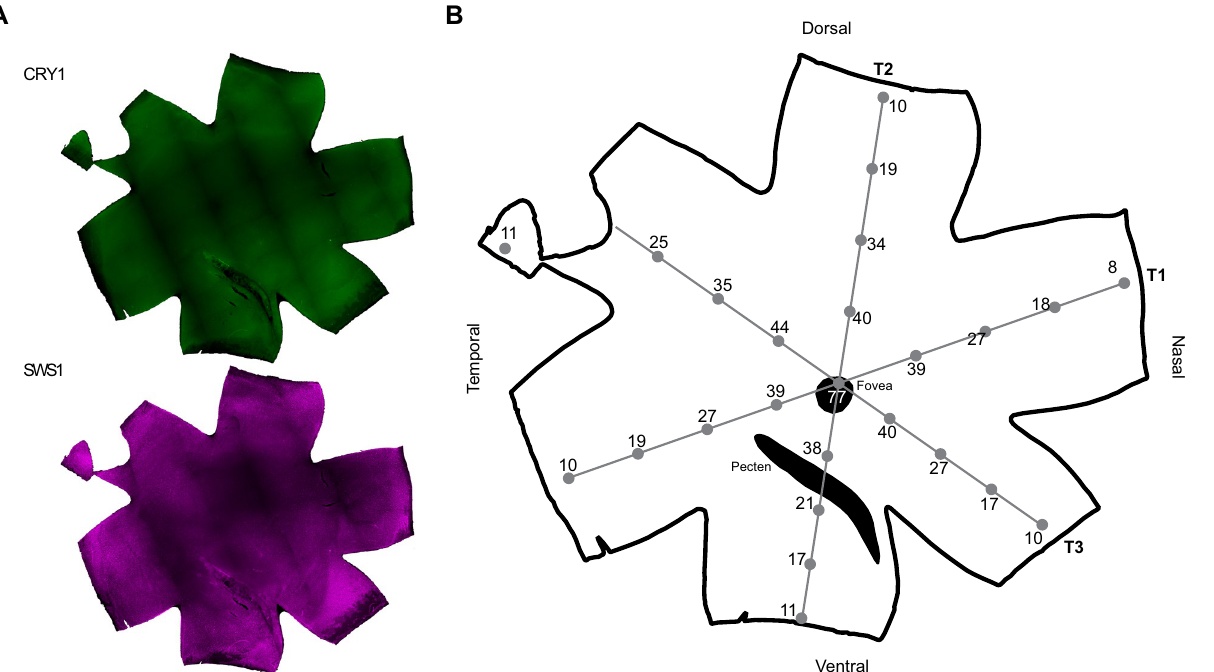
Figure 4. Example of a whole-mounted retina of a zebra finch. ( A ) Whole-mounted retina showing a positive signal for CRY1 (upper image in green) and for SWS1 opsin (lower image in purple). The image is from a left eye retina, mounted with the photoreceptors side up. The banded pattern is an artefact of the digital reconstruction of the entire image from smaller images at higher magnification. The darker regions towards the centre of the retina correspond to thicker remains of pigment epithelium. ( B ) Schematic of the entire retina shown in ( A ). The grey lines and dots show the sampling transects (T1, T2 and T3) and locations where the immunopositive signals were counted. The numbers (× 100) give the counts of positive CRY1/SWS1 cells calculated for a 1 mm 2 area at the respective locations of the retina. Bar: 2